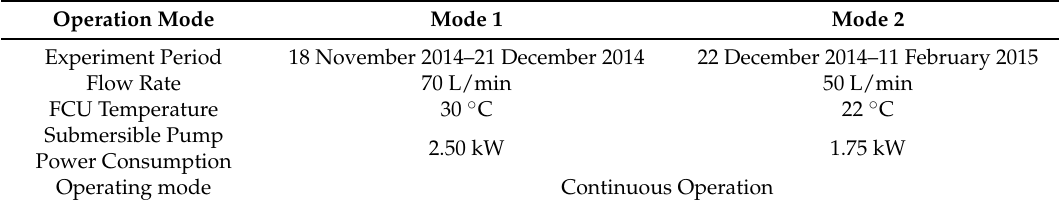
Table 3. Summary of the